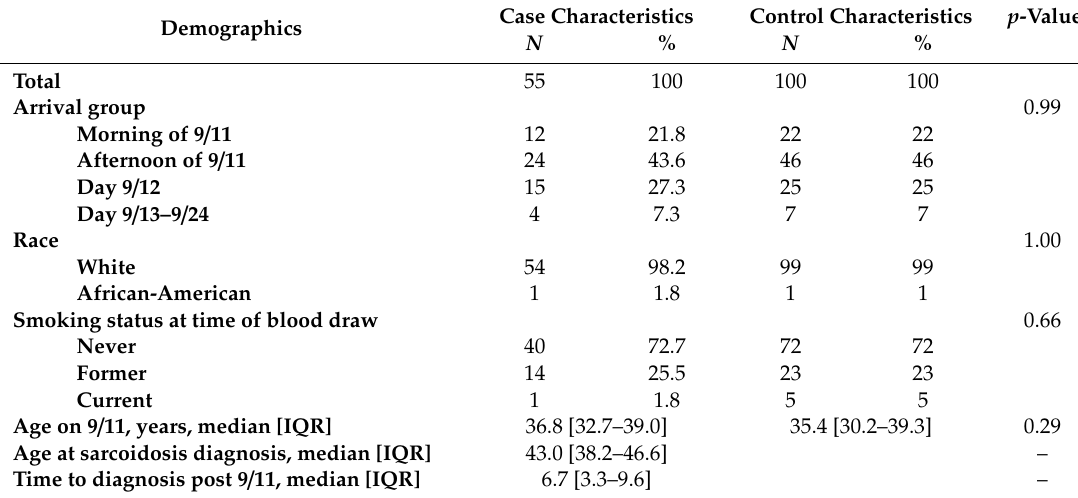
Table 1. Demographics of WTC Study